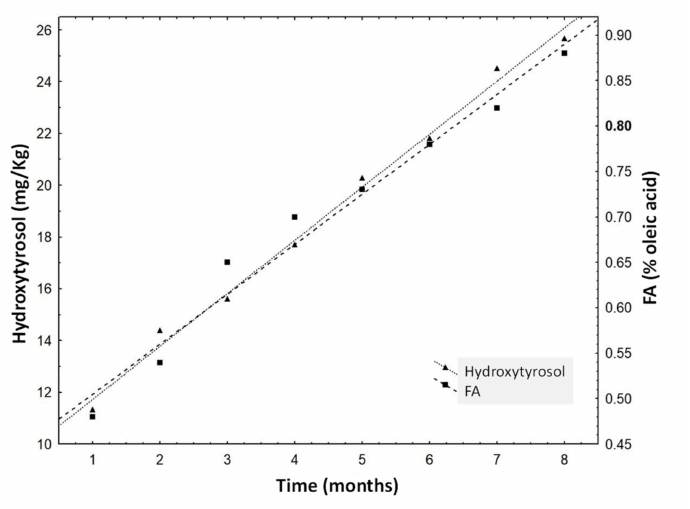
Figure 2. Free acidity (FA) of the control samples throughout the storage experiment. The limit of FA is 0.8% for EVOO